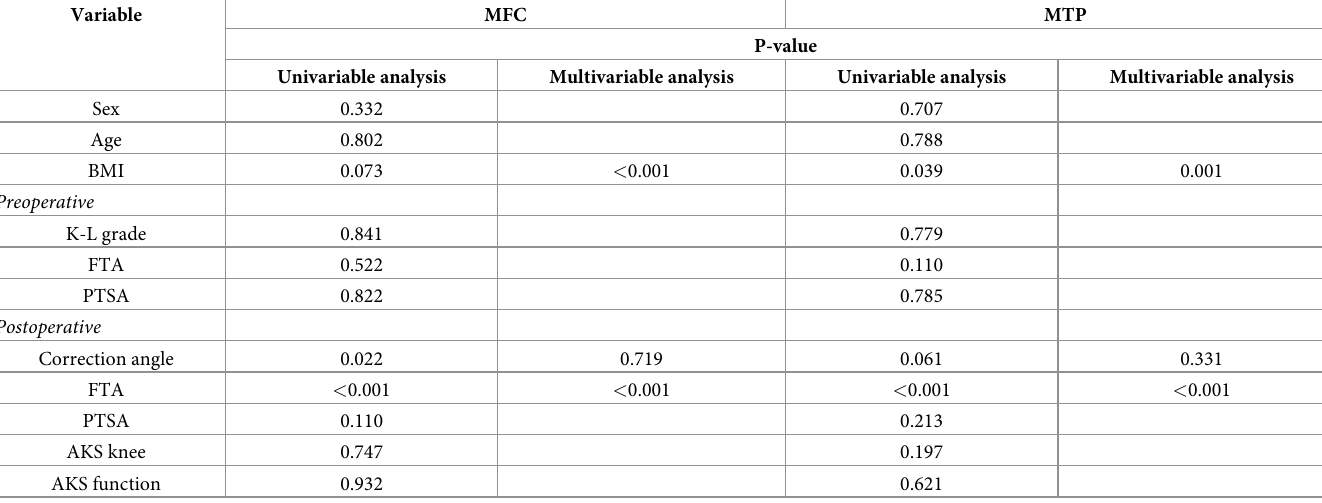
Table 3. Univariable and multivariable postoperative BTU analysis of the medial compartment.